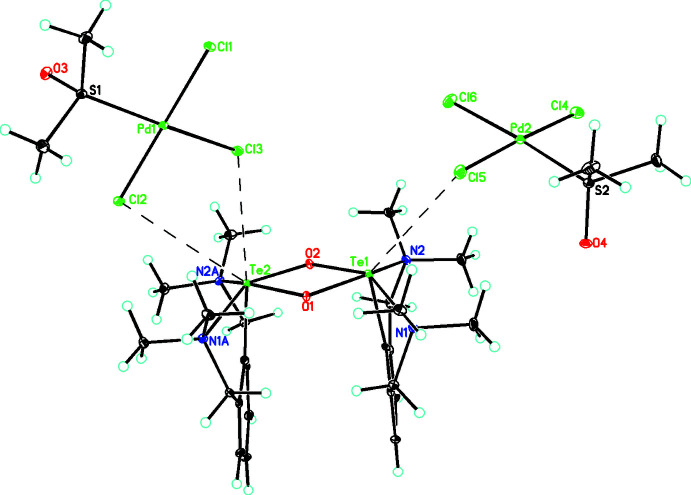
Diagram of the [C24H38N4O2Te2]2+ anion and the [PdCl3(DMSO)]− anions linked by Te⋯Cl inter­actions (shown as dashed lines).